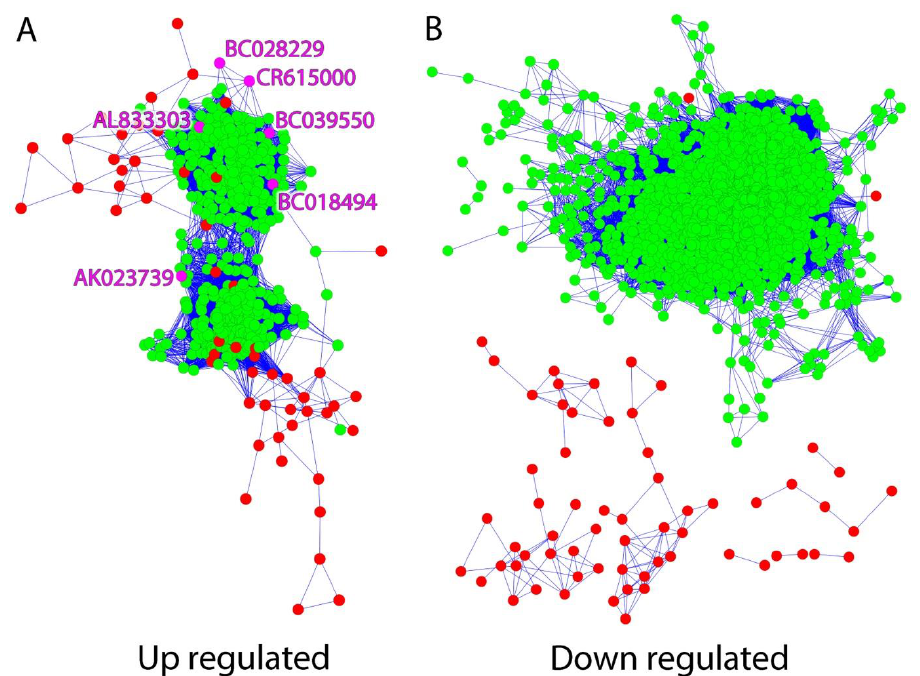
Figure 1. MAPK-pathway signaling genes and specific lncRNAs are co-differentially expressed in an activity-dependent fashion in human epileptic brain tissues. Gene clustering of microarray re- sults from seven patients with neocortical epilepsy demonstrates that certain lncRNAs (green) have significantly similar expression patterns to the MAPK-pathway signaling genes (red). Each node (green, red or magenta circles) corresponds to a gene and each link between nodes correspond to a Pearson correlation p-value p < 0.00001 (R > 0.9, 14 samples), indicating that the closer two linked nodes are to each other, the more closely their expression patterns resemble each other. LncRNAs of interest (magenta) were identified and subsequently labeled. (A) Clustering of MAPK-pathway signaling genes with upregulated lncRNAs shows 231 significantly upregulated lncRNA and 42 MAPK signaling genes with a similar expression pattern (fold change > 1.3, false discovery rate < 5%). (B) Clustering of MAPK-pathway signaling genes with downregulated lncRNAs shows that the MAPK-pathway signaling genes does not cluster with the down regulated lncRNAs..